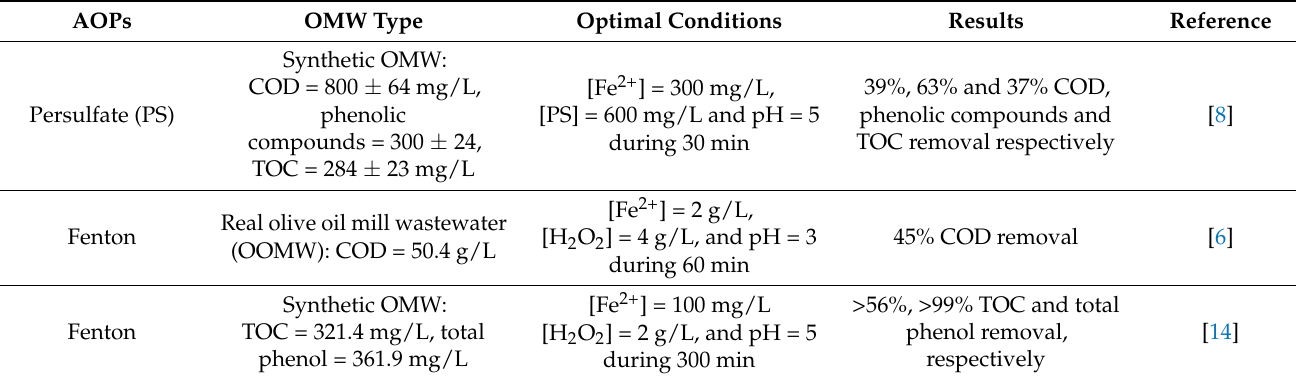
Table 1. Examples of AOPs and SRbAOPs on OMW